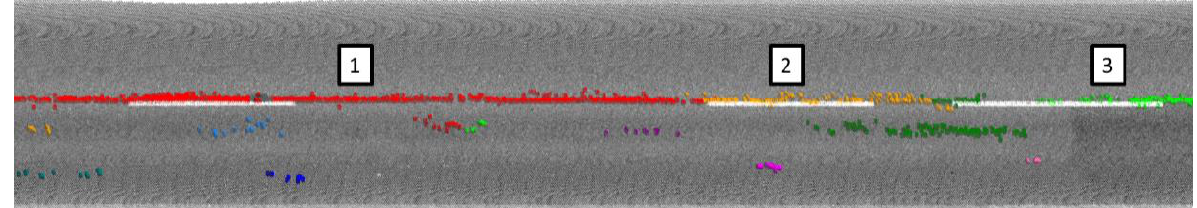
Figure 13. Road spot 2. Crack points detected with the proposed algorithm, grouped in clusters by color.